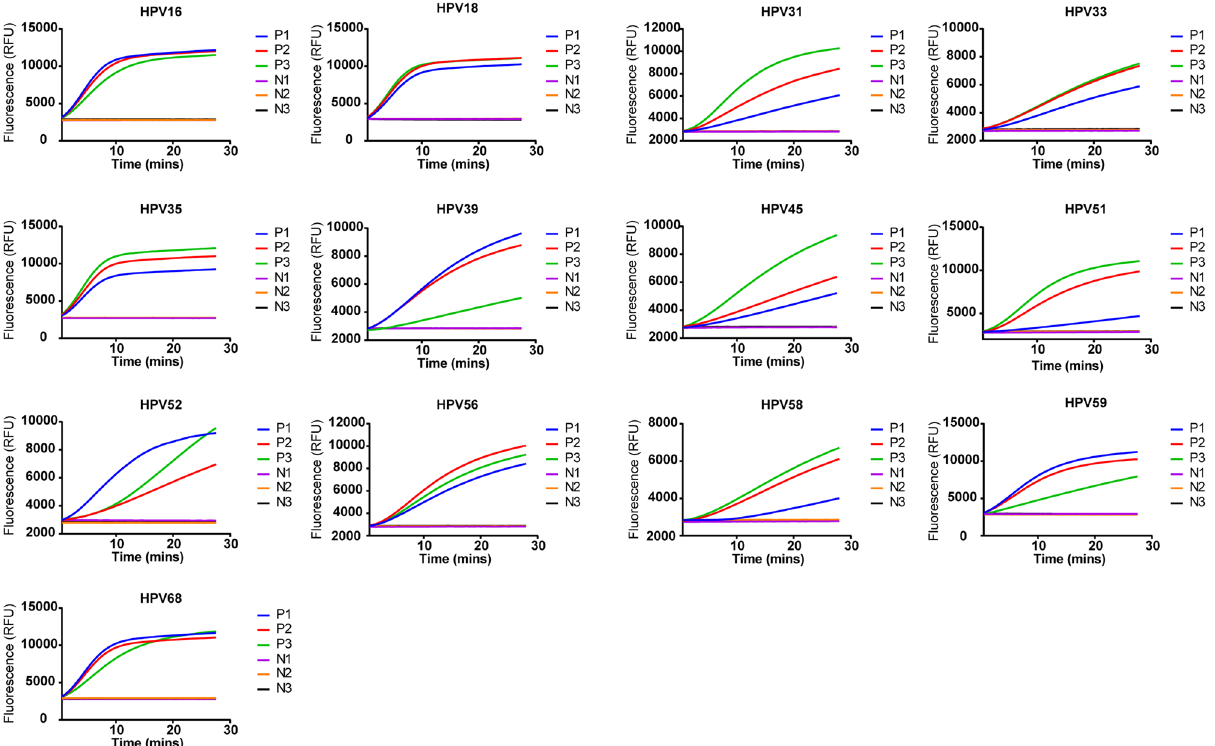
Figure 6. Clinical validation. Three positive and three negative samples identified by qPCR were used for testing for each type. The developed assay had 100% positive and negative agreements relative to the qPCR assay, for detection of the 13 types of HR-HPVs. P positive, N